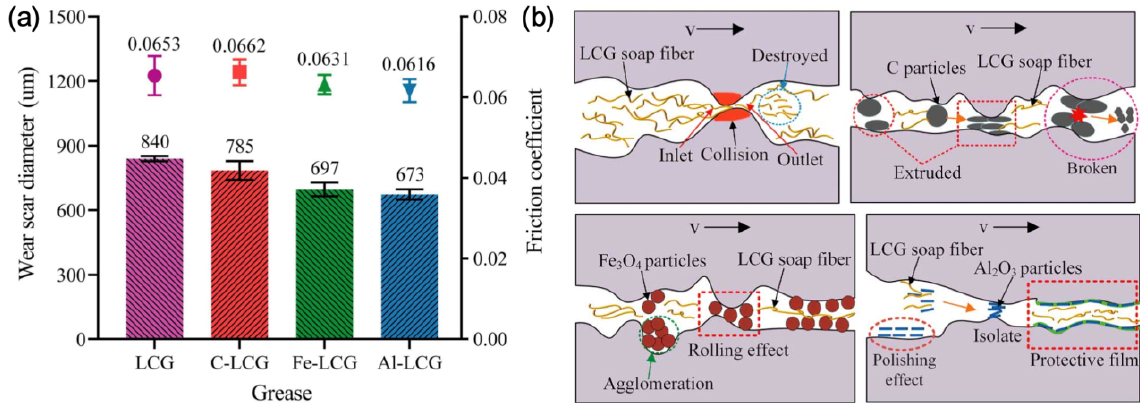
Fig. 7 (a) Friction coefficient and wear scar diameter of LCG, C-LCG, Fe- LCG, and Al-LCG (four-ball, 1,200 rpm, 392 N, 60 min). (b) Schematic diagrams of the lubricating mechanism of four kinds of greases [95]. Reproduced with permission from Ref. [95], © Elsevier Ltd.,